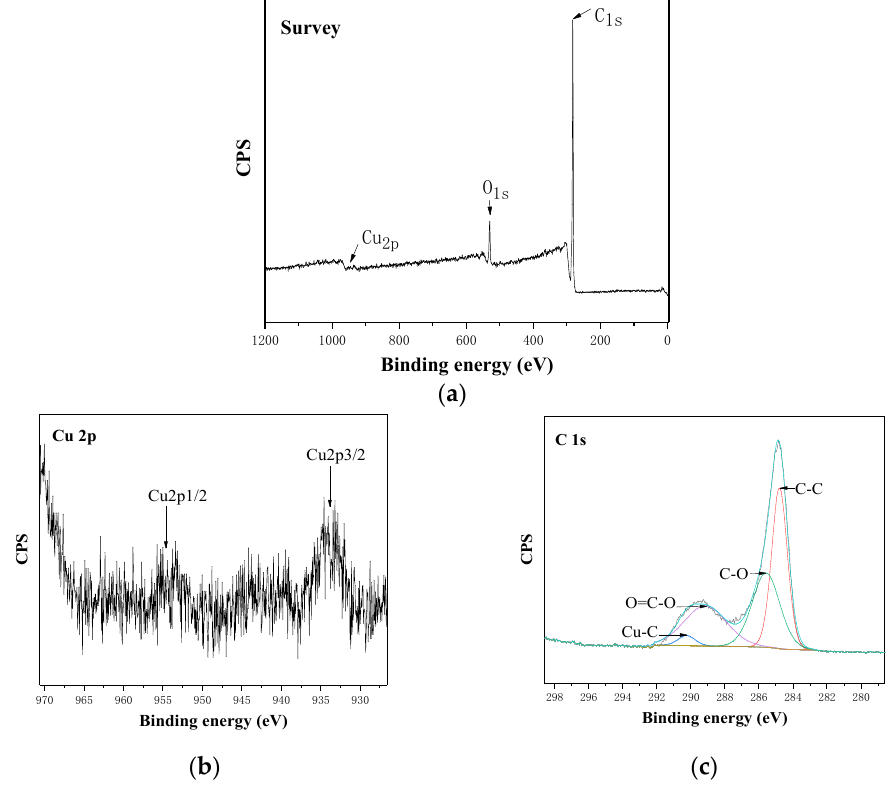
Figure 6. X-ray electron spectroscopy (XPS) spectra of superhydrophobic copper modified in an ethanol solution of SA for 30 h: ( a ) survey; ( b ) Cu 2 p spectra; ( c ) C 1 s spectra.